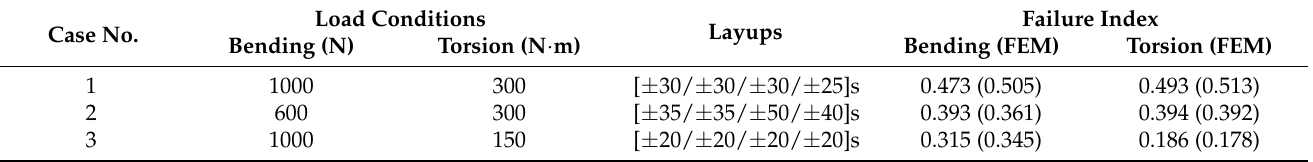
Table 2. The designs of the layups with optimum strength values under several load conditions.